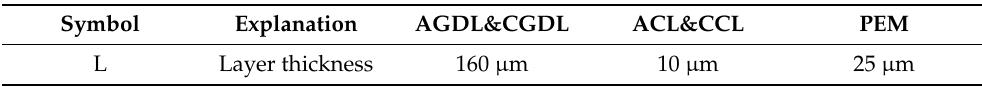
Table 2. Material and through-plane transport